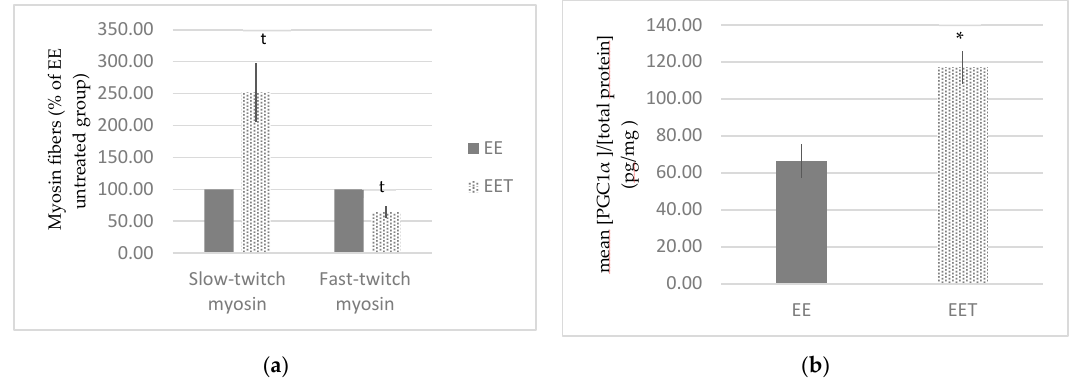
Figure 4. Influence of melon concentrate supplementation on the gastrocnemius protein expression of myosin fibers and the PGC1 α plasma level. ( a ) Quantification was made after standardization within membranes by expressing the density of the band of slow ‐ twitch or fast ‐ twitch myosin relative to that of tubulin in the same lane. Results are then expressed as relative change from untreated EE band intensity ± SEM. t p < 0.1 effect of melon concentrate supplement compared with the EE group. ( b ) Results are expressed as mean [PGC1 α ]/[total protein] (pg/mg) ± SEM. * p < 0.05 effect of the melon concentrate supplementation in the context of an eccentric exercise compared with EE group.